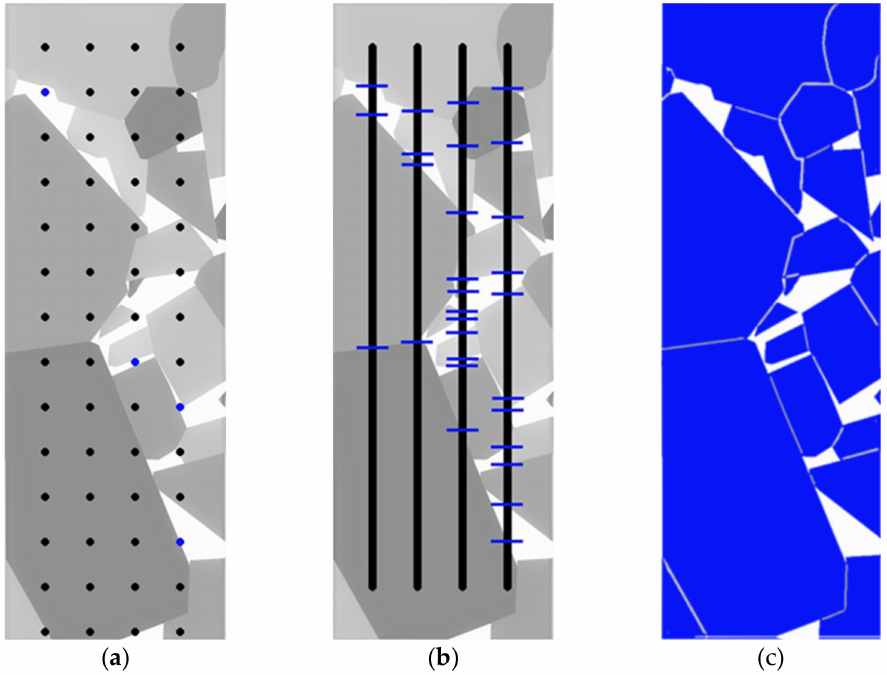
Figure 1. Schematic illustration of the analysis methods: ( a ) PA with black points situated inside the grains counted; ( b ) PA with blue strokes indicating the grain boundaries; and ( c ) AA with blue blocks indicating the